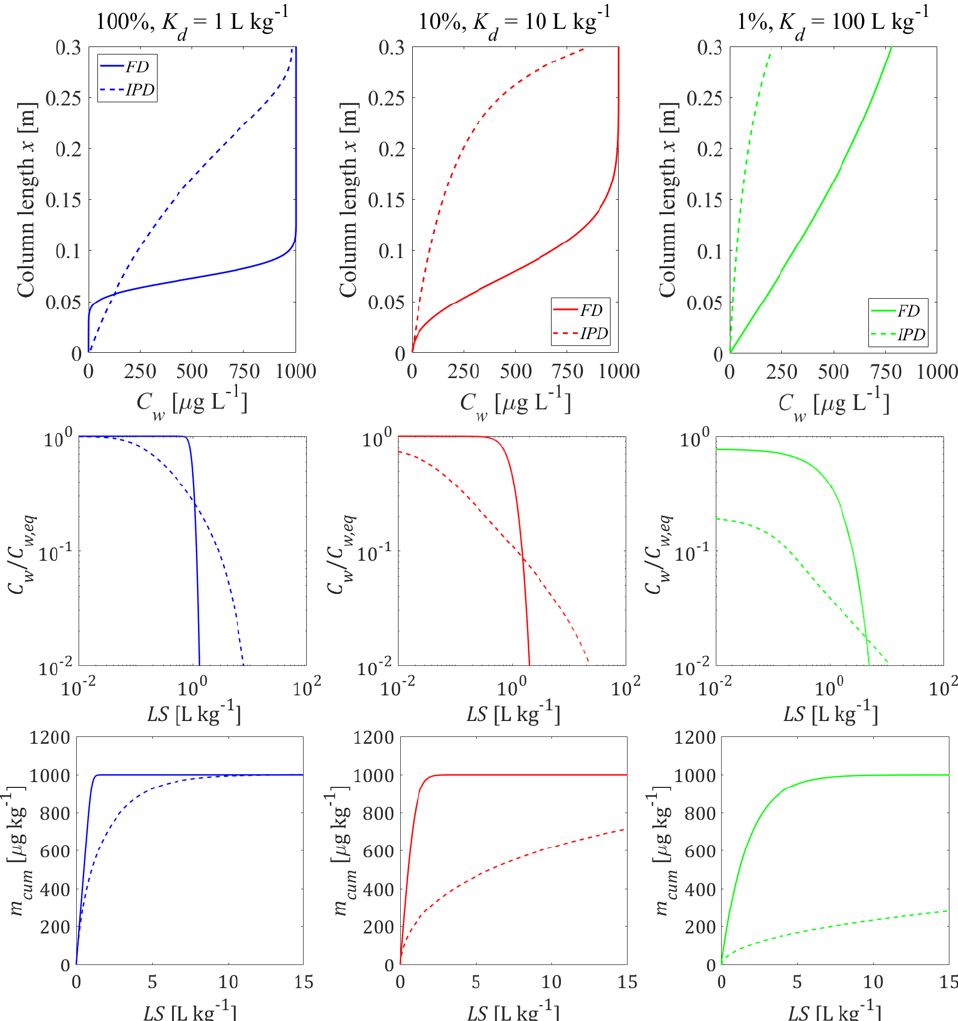
Figure 9. Behavior of bi-modal material compositions of sorbing and non-sorbing particles: initial concentration distribution in the column after the first flooding ( top panel ) and column effluent concentration (normalized: mid panel , cumulative: bottom panel ) vs. time (expressed as liquid to solid ratio: LS). Left column: homogeneous case with average K d (= K d , av = 1 L kg − 1 ); mid column: only 10% of the particles carry the contaminant at K d = 10 × K d , av ; right column: only 1% of the particles carry the contaminant at K d = 100 × K d , av ; the average K d , av of the entire material is the same for all compositions; solid lines: film diffusion cases, dashed lines: intraparticle diffusion case; n = 0.45, v = 1.67 × 10 − 5 m s − 1 , α = 0 (no dispersion), C s , ini = 1000 µ g kg − 1 , t c = 5 h, D aq = 1 × 10 − 9 m 2 s − 1 , ε = 0.05, d p , coarse = 2000 µ